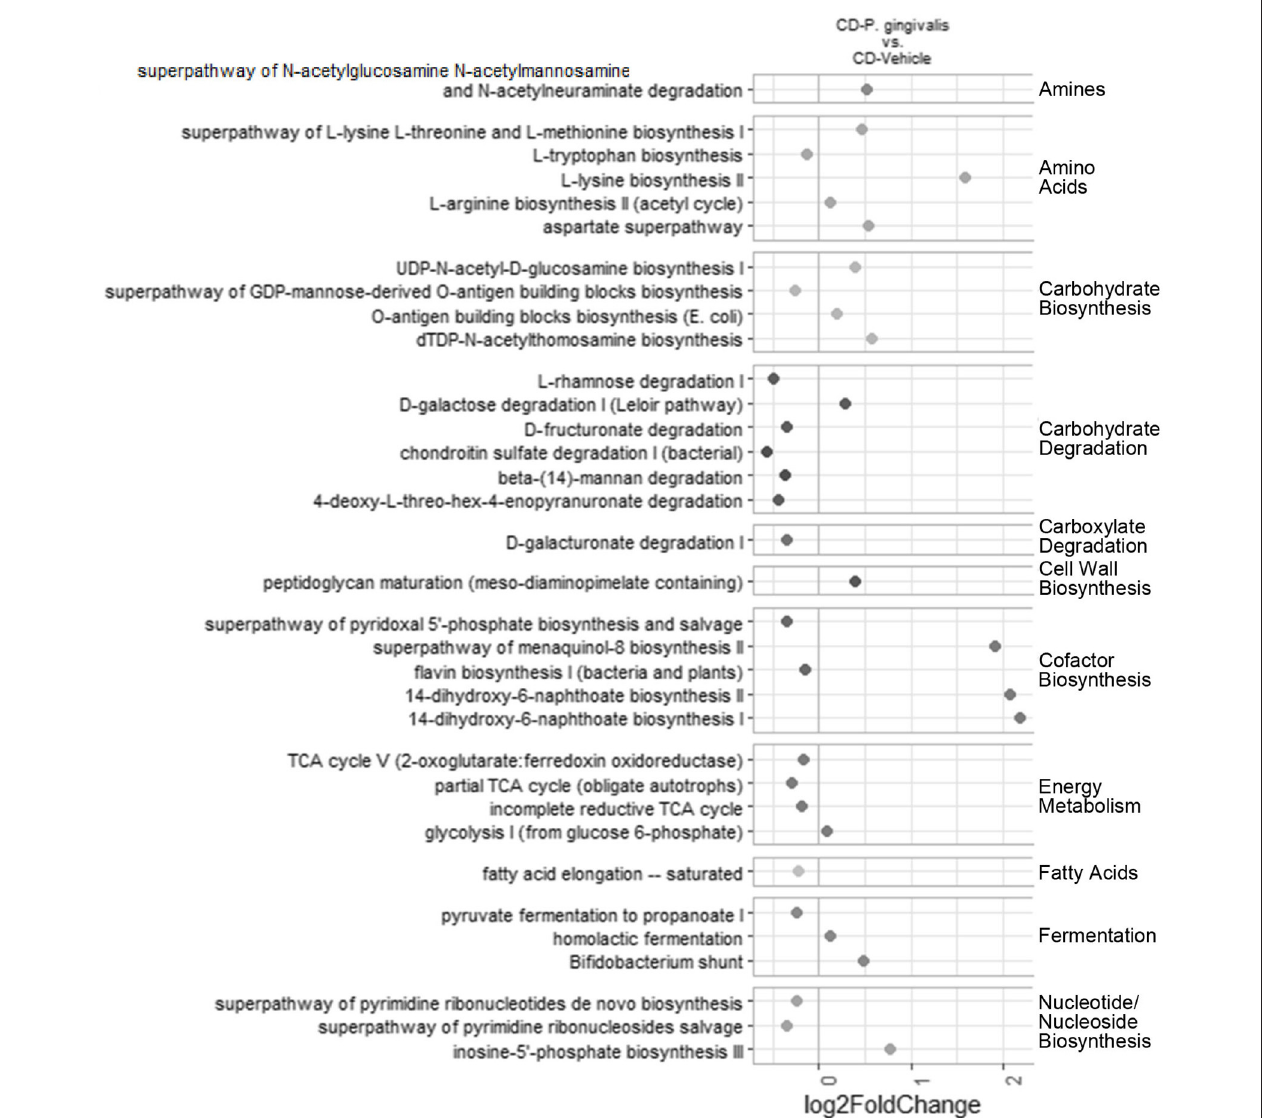
FIGURE 6 | Chronic P. gingivalis infection persistently disrupts microbiota function in mice fed a control diet. Predicted pathways expected to be differentially abundant due to P. gingivalis infection of mice fed a CD. Significance assessed by DESeq2 with an adjusted p -value <